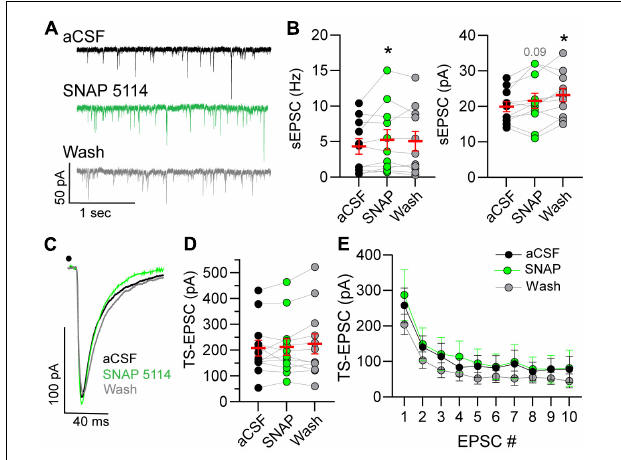
FIGURE 4 | Spontaneous glutamatergic activity increases in GAT-block. (A) Example of spontaneous excitatory postsynaptic current (sEPSCs) increase during GAT-3 block with SNAP 5114. Recordings occur in potassium-gluconate pipette solution. (B) An augmentation in frequency (Hz, left ) occurred whereas amplitude (pA, right ) progressively increased over time. RM one-way ANOVA with LSD post hoc : Freq left, F (2,20) = 2.320; Ampl right, F (2,20) = 6.026, * p ≤ 0.05 vs aCSF. (C) Representative traces of TS-EPSCs evoked by 0.5 Hz stimulation during aCSF, SNAP 5114 and wash. Overall, TS-EPSC amplitude did not change during 0.5 (D) or 20 (E) Hz afferent stimulation in the presence of GAT-3 inhibition. (D) RM one-way ANOVA with LSD post hoc : F (2,22) = 1.055. (E) Mixed-effects model (REML), EPSC main factor, F (9,81) = 26.04, drug main factor, F (2,18) = 0.4005, interaction, F (18,142) = 0.8677. Data in (B,D) (left) are shown as individual neurons (connected circles), their responses, and means ± SEM in red. * p ≤ 0.05.